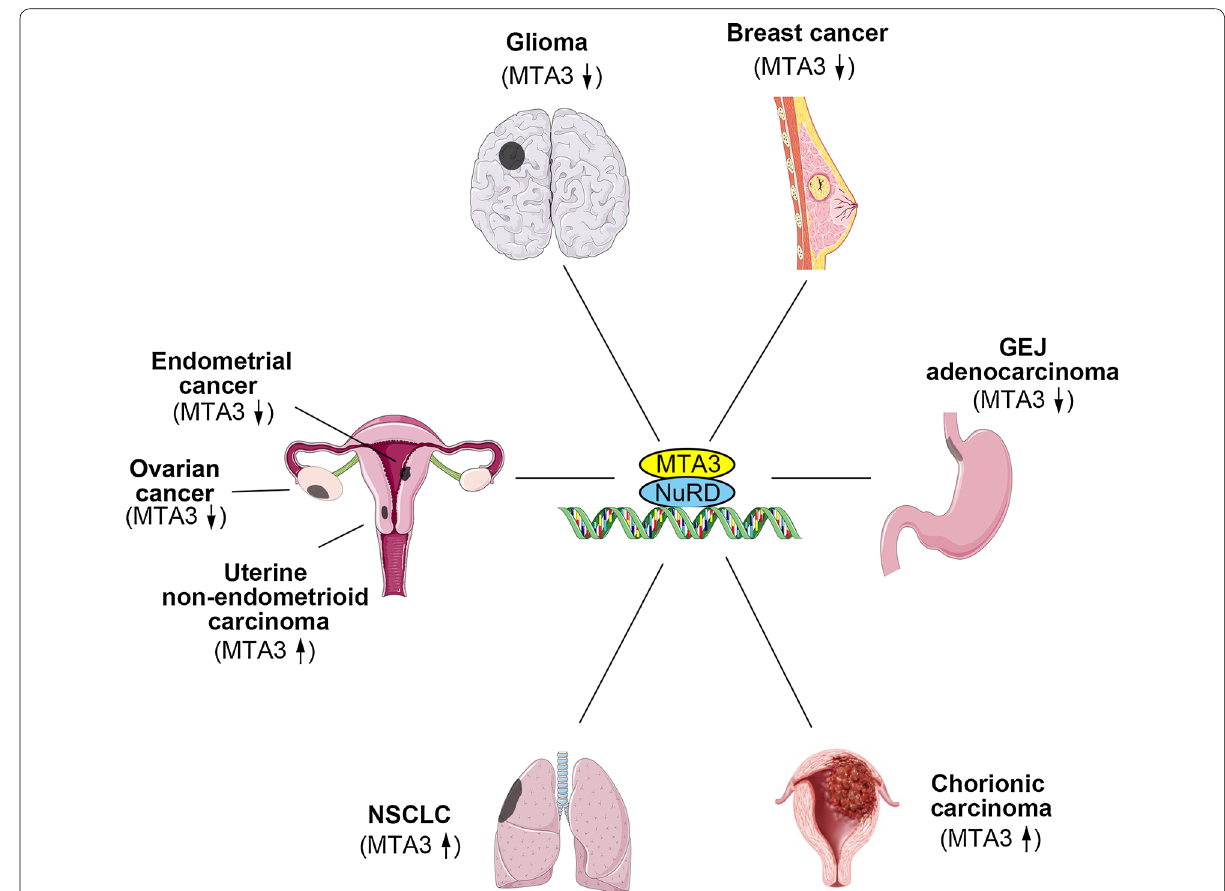
Fig. 3 Aberrant expression of MTA3 in a host of human tumor types. NSCLC non-small cell lung cancer, GEJ gastroesophageal junction, NuRD nucleosome remodeling and histone